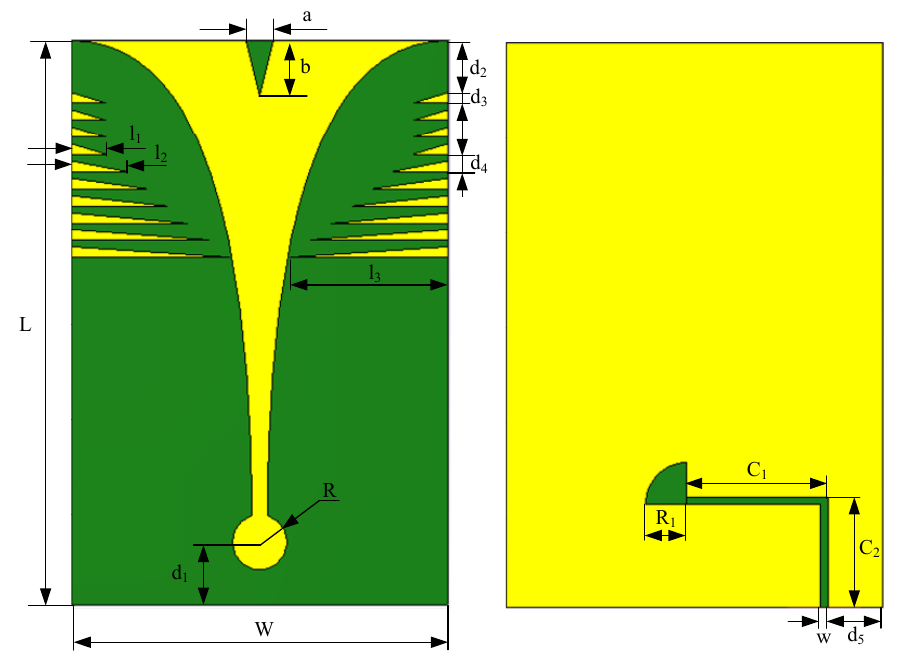
Figure 4. Vivaldi narrow-beam antenna structure (front and back). Table 3. Final optimization results of the parameters of Vivaldi narrow-beam antenna (mm).